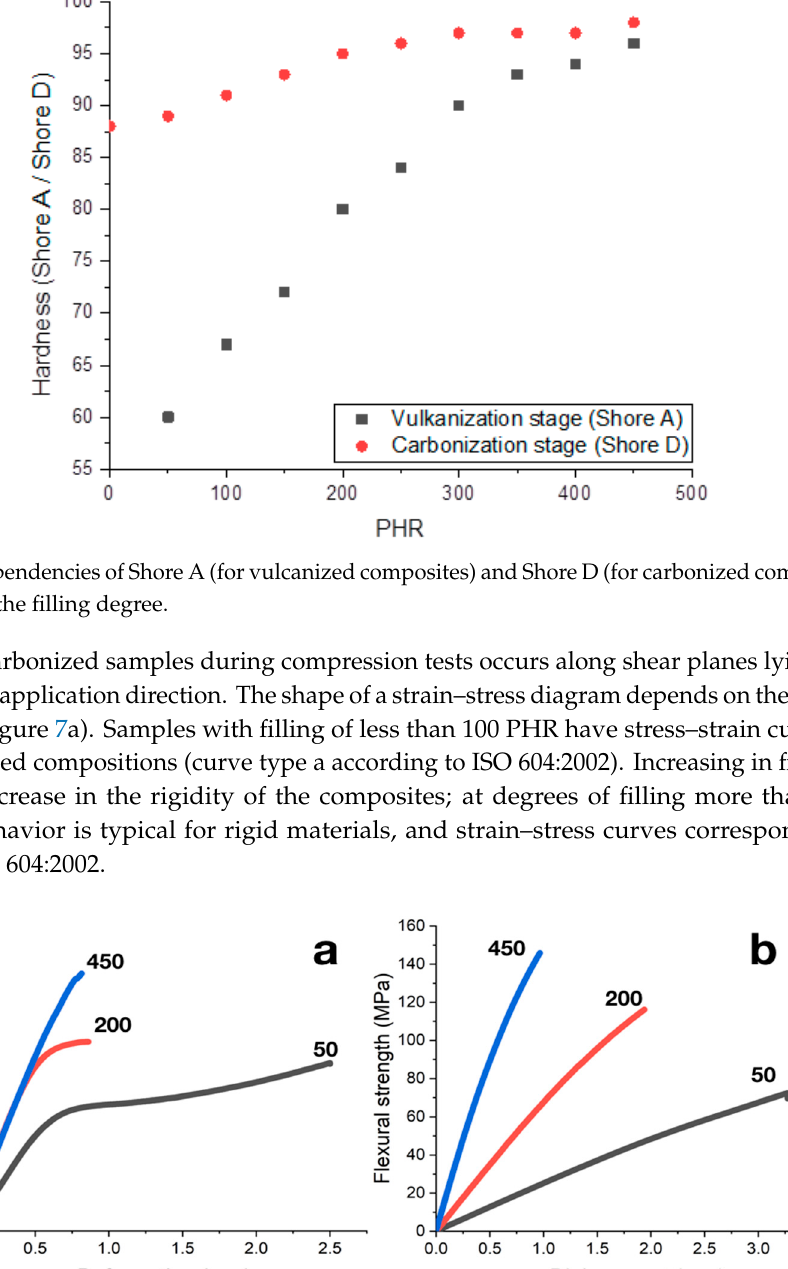
Figure 8. Concentration dependencies of strength ( a ) and Young modulus ( b ) from compression tests of carbonized samples. Concentration dependencies of the carbonized samples’ thermal diffusivities (Figure 10a and Table 1), along with in the case of compressive strength, can be divided into three stages differing in the rate of thermal diffusivity increase. An increase in the measurement temperatures in the range of 25–300 °C resulted in the decrease in thermal diffusivity by 25–30% (Figure 10b). Concentration and temperature dependencies of thermal conductivity coefficient calculated by formula (1) are given in Figure 10c,d; see also Table 1. The thermal conductivity of the obtained composites slightly depends on the temperature, whereas increase in the filling degree results in the increase in thermal